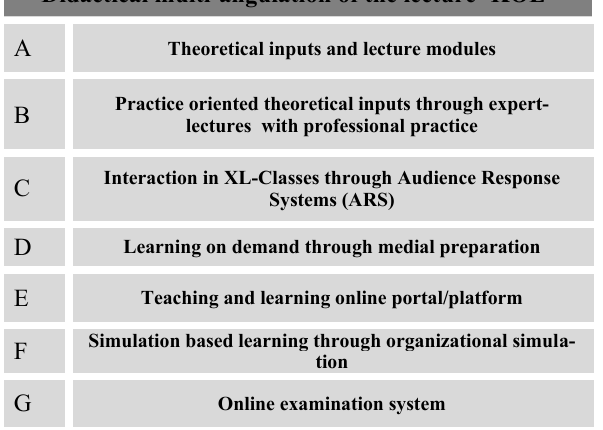
Figure 1. Didactical elements ‘KOE’ lecture at RWTH Aachen Uni- versity